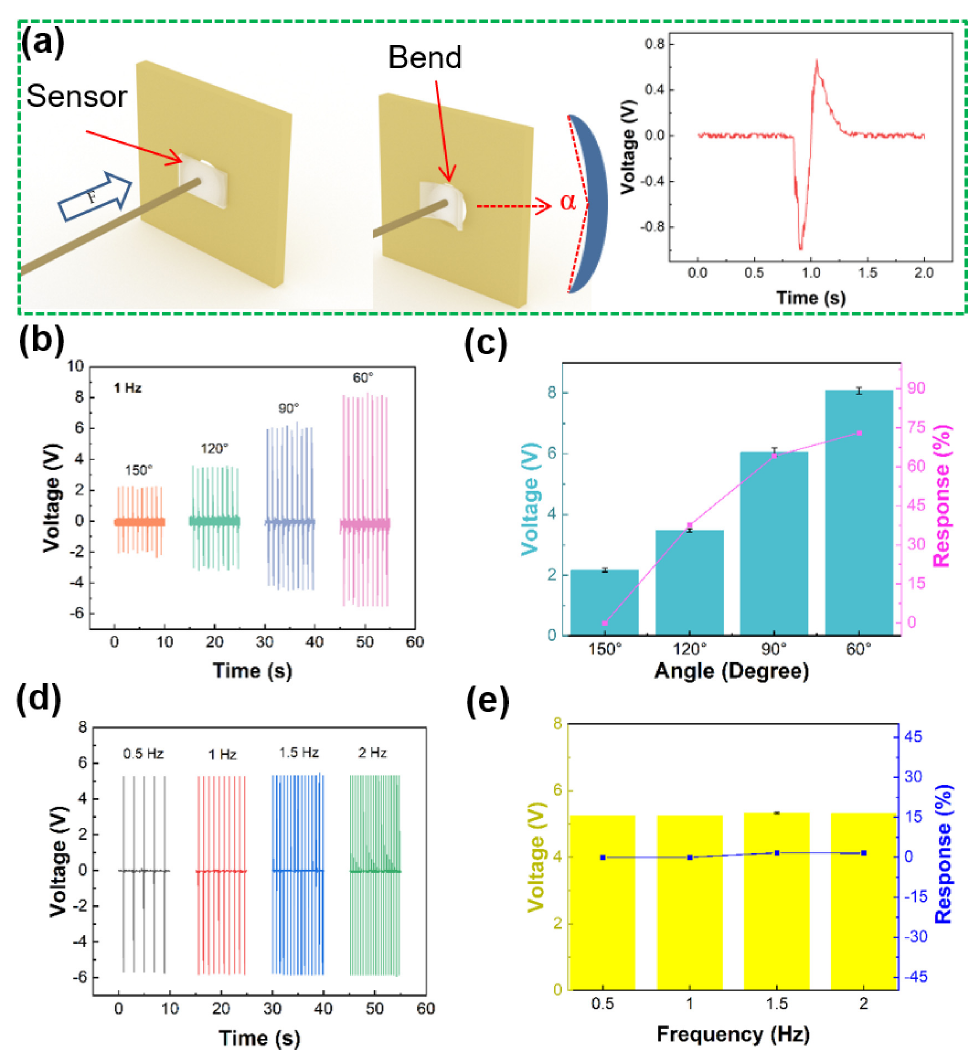
Figure 3. Sensing ability test of sensor. ( a ) Schematic diagram of sensor deformation and output voltage. ( b ) Output piezoelectric voltage at different working angles of sensor. ( c ) Output piezoelectric response. ( d ) Output piezoelectric voltage at different operating frequencies. ( e ) Piezoelectric output response.